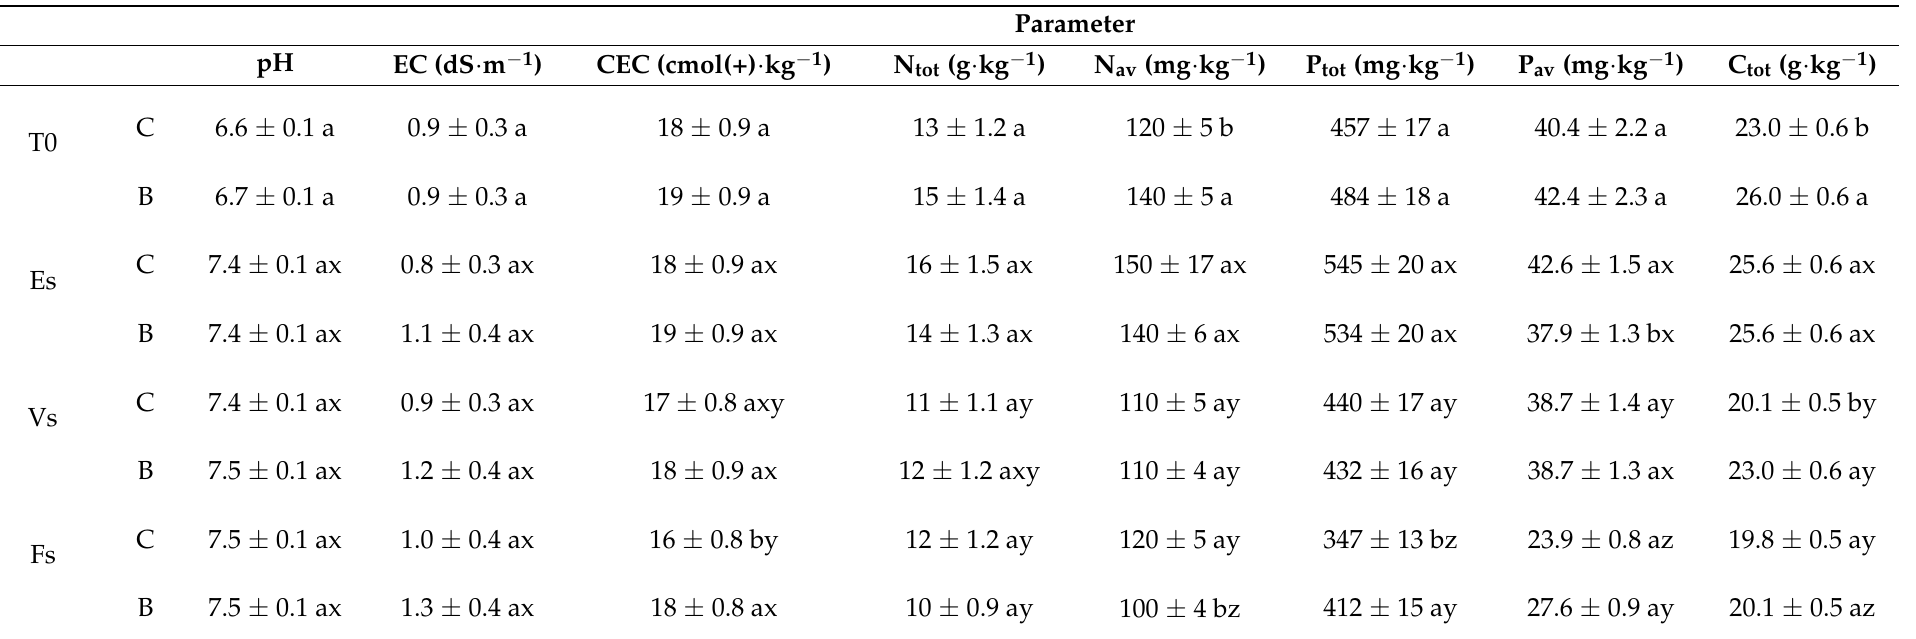
Table 2. Physicochemical characteristics of untreated (C) and biochar-treated (B) substrates were determined at the beginning of the experiment (T0) and early stage (Es, 36 days after plant germination), vegetative stage (Vs, 84 days after plant germination), and fruit stage (Fs, 140 days after plant germination). Letters a and b indicate a statistically significant difference ( p < 0.05) between the two treatments inside each sampling point. Letters x, y, and z indicate a statistically significant difference ( p < 0.05) among the Es, Vs, and Fs sampling points for each treatment. ( n = 8 ±